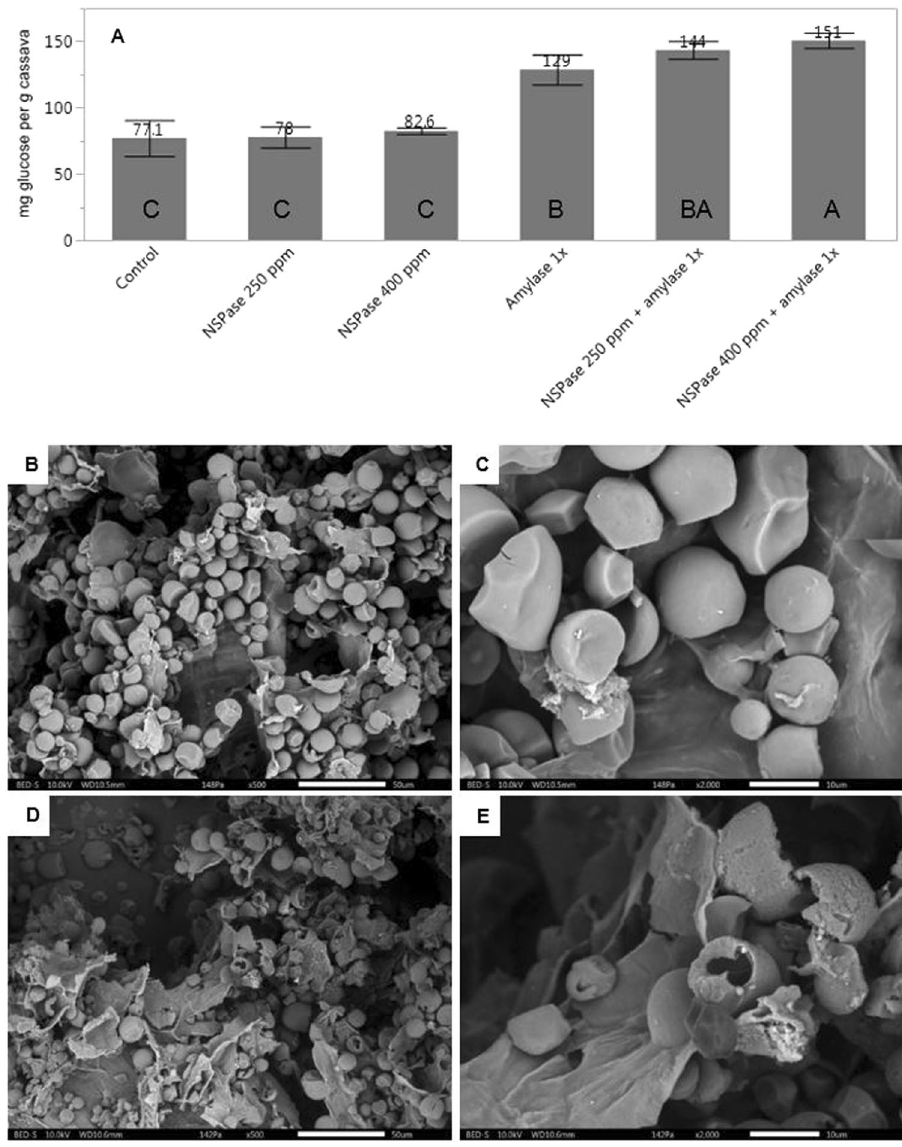
Figure 3. Effect of combinations of enzyme supplementation (A) HPIC quantification of glucose in the hydrolysed supernatant, given in mg per g of cassava sample. ( B) SEM picture of milled cassava D treated without enzymes. Magnification of 500x and scale bar equal to 50 µ m. ( C) SEM picture of milled cassava D treated without α -amylase. Magnification of 2,000x and scale bar equal to 10 µ m. (D) SEM picture of milled cassava D treated with α -amylase. Magnification of 500x and scale bar equal to 50 µ m. ( E) SEM picture of milled cassava D treated with α -amylase. Magnification of 2,000x and scale bar equal to 10 µ